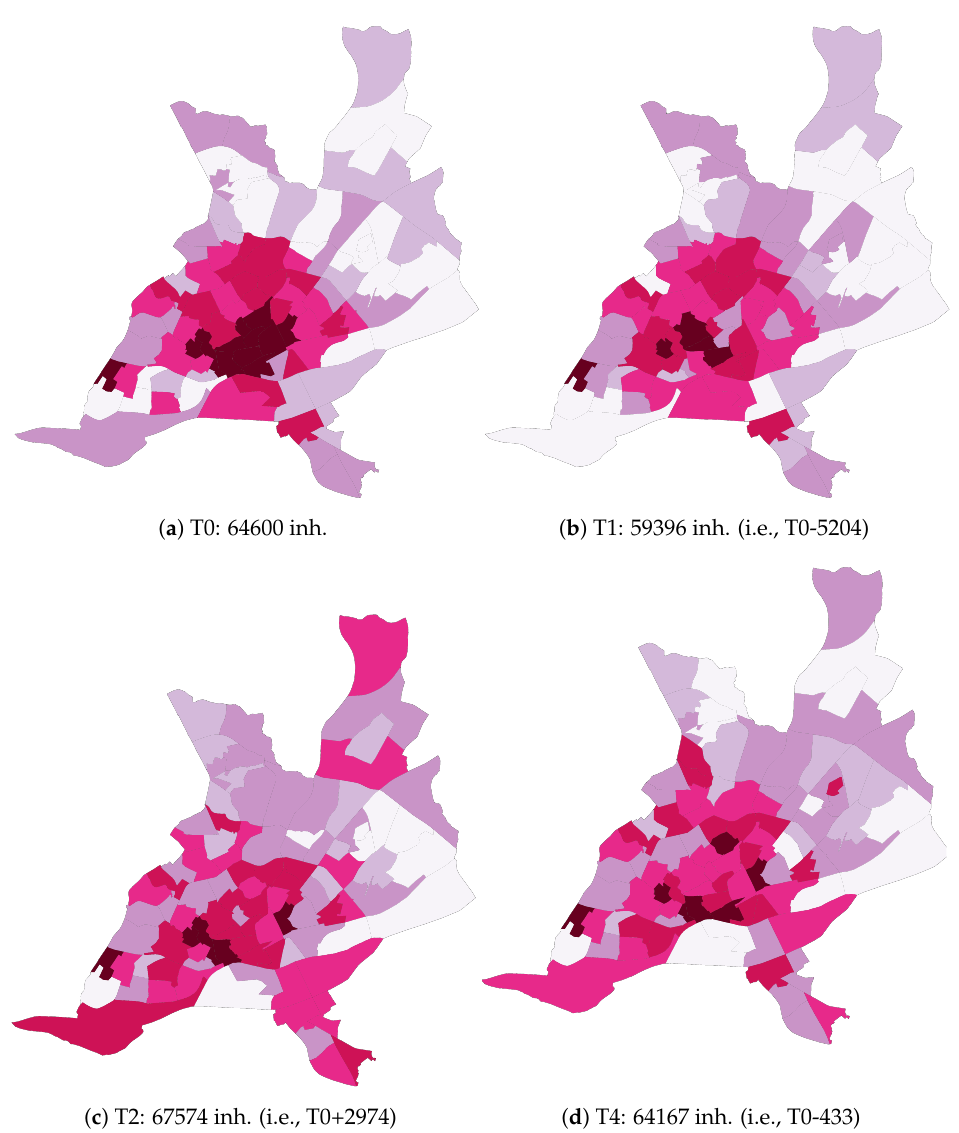
( c ) T2: 67574 inh. (i.e., T0+2974) ( d ) T4: 64167 inh. (i.e., T0-433) Figure 14. Percentage of inhabitants exposed to noise levels exceeding a threshold value of 68 dB: ( a ) reference T0 (2008); ( b ) Scenario T1; ( c ) Scenario T2; and ( d ) Scenario